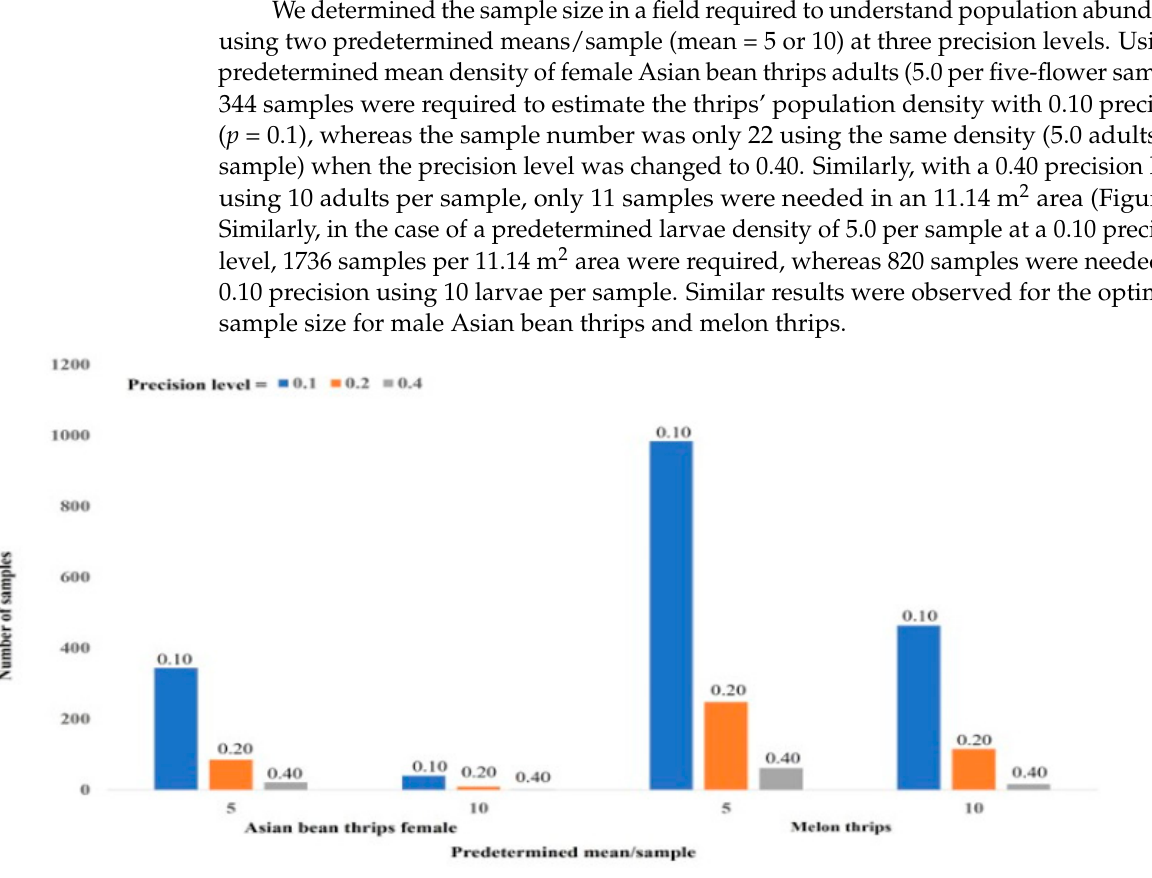
Figure 2. Determination of sample size by using three levels of precision at predetermined densities of 5 and 10 thrips/leaf sample. of 5 and 10 thrips/leaf